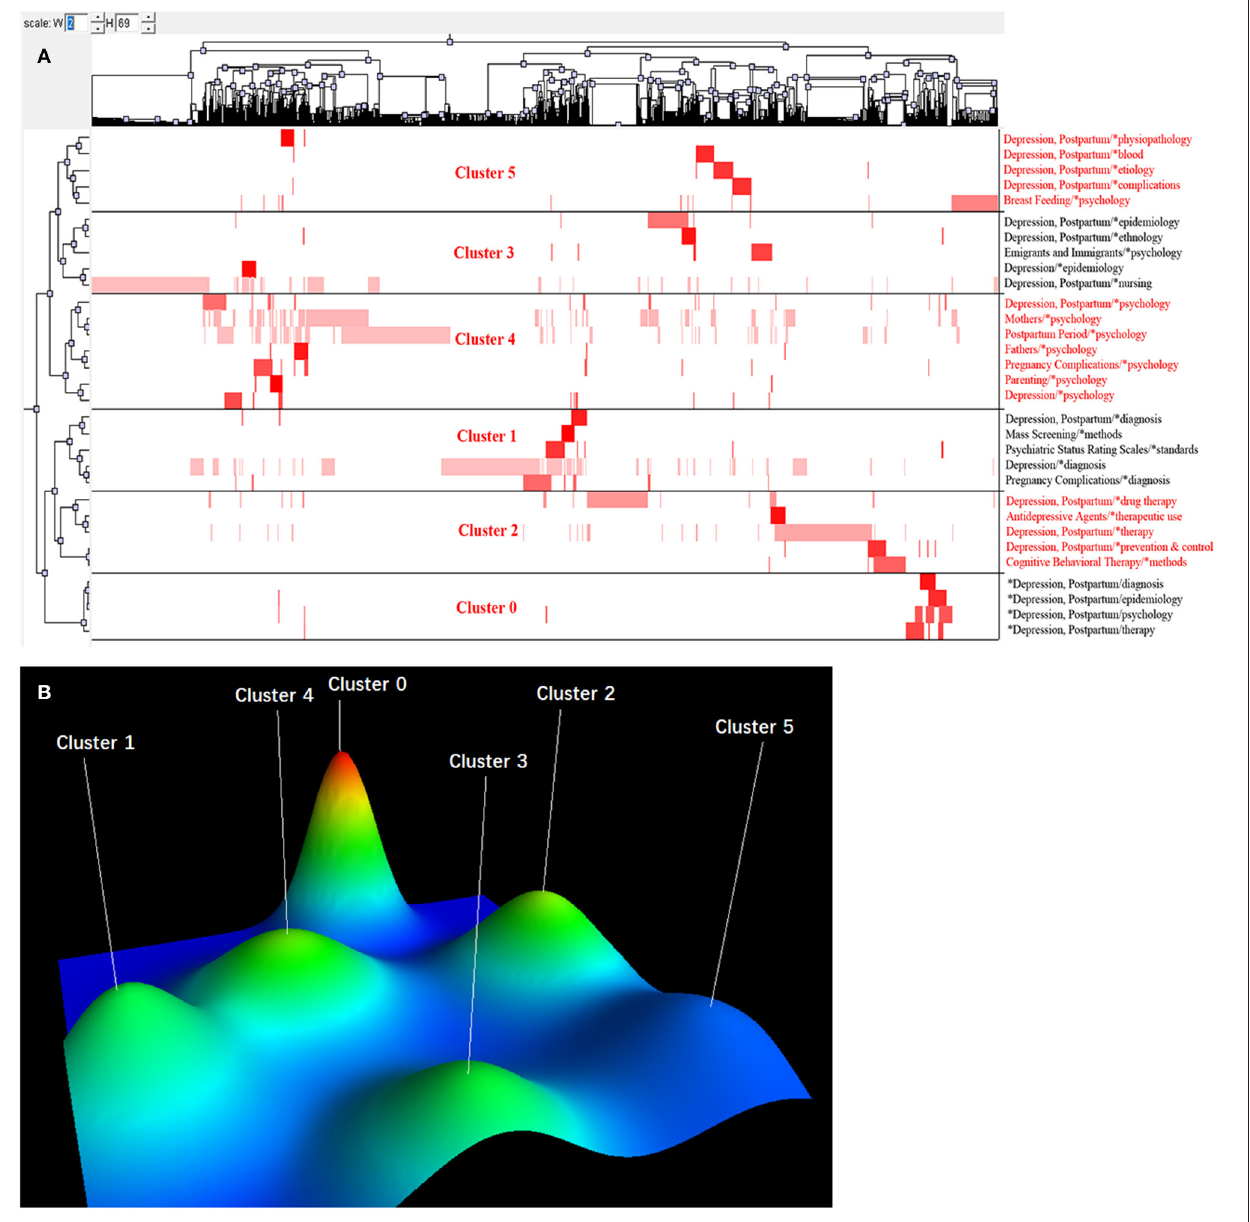
FIGURE 4 | Biclustering analysis of 31 high-frequency main Medical Subject Heading (MeSH) terms/subheadings and articles on postpartum depression from 2000 to 2020. (A) Matrix visualization of biclustering of 31 high-frequency main MeSH terms/subheadings and PubMed Unique Identifiers of the articles. (B) Mountain visualization of biclustering of 31 high-frequency main MeSH